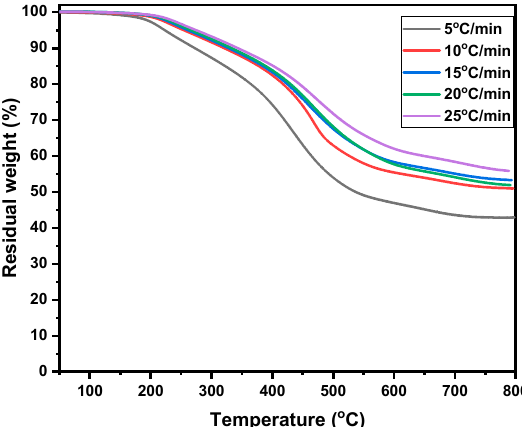
ff erent heating